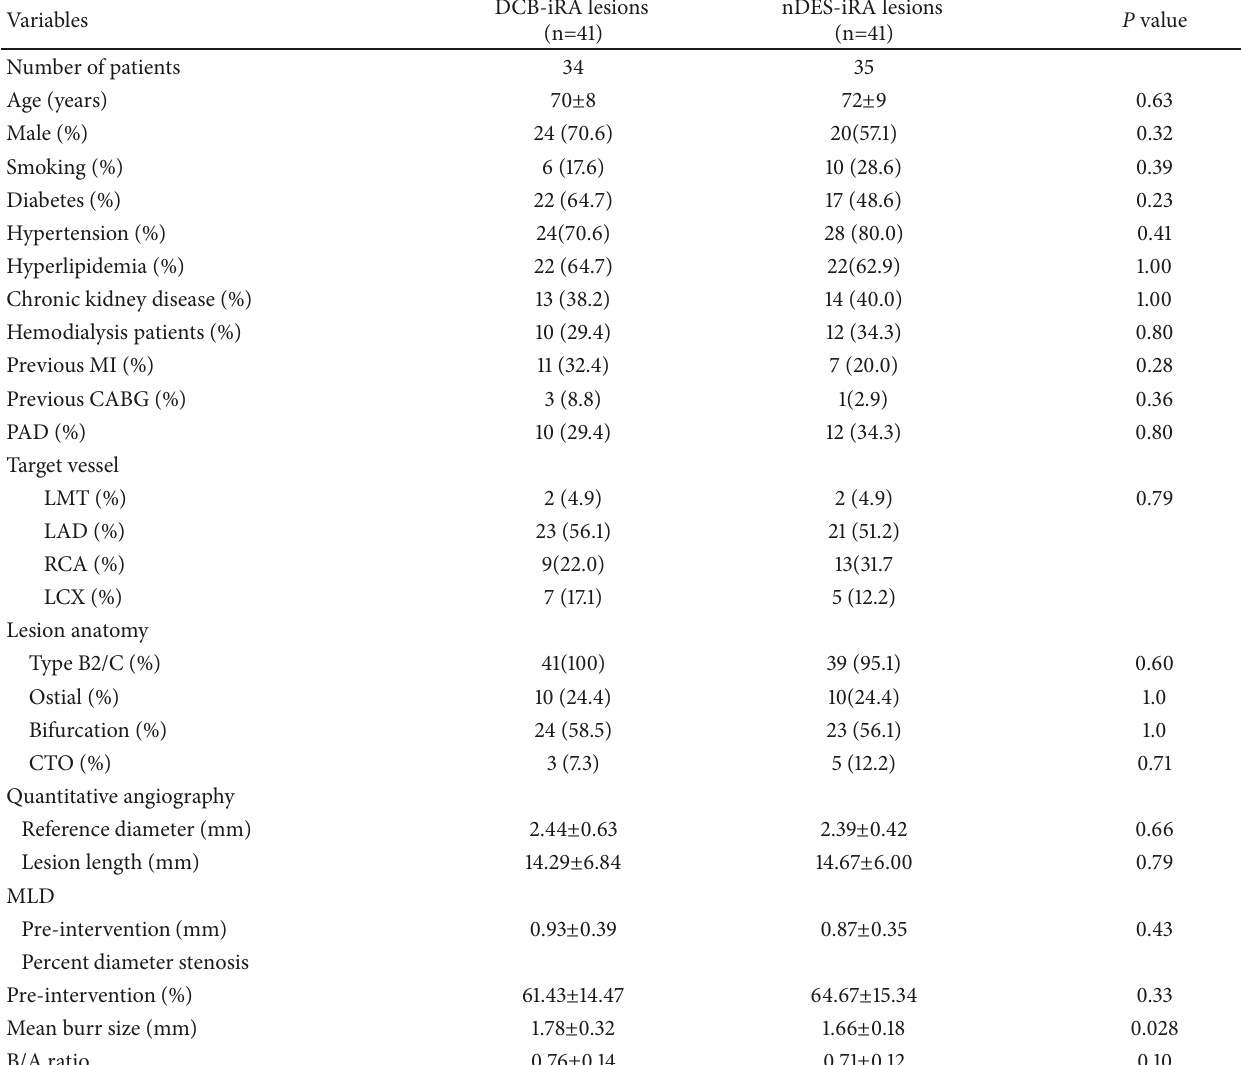
Table 4: Baseline characteristics of patients and lesions in the propensity-matched